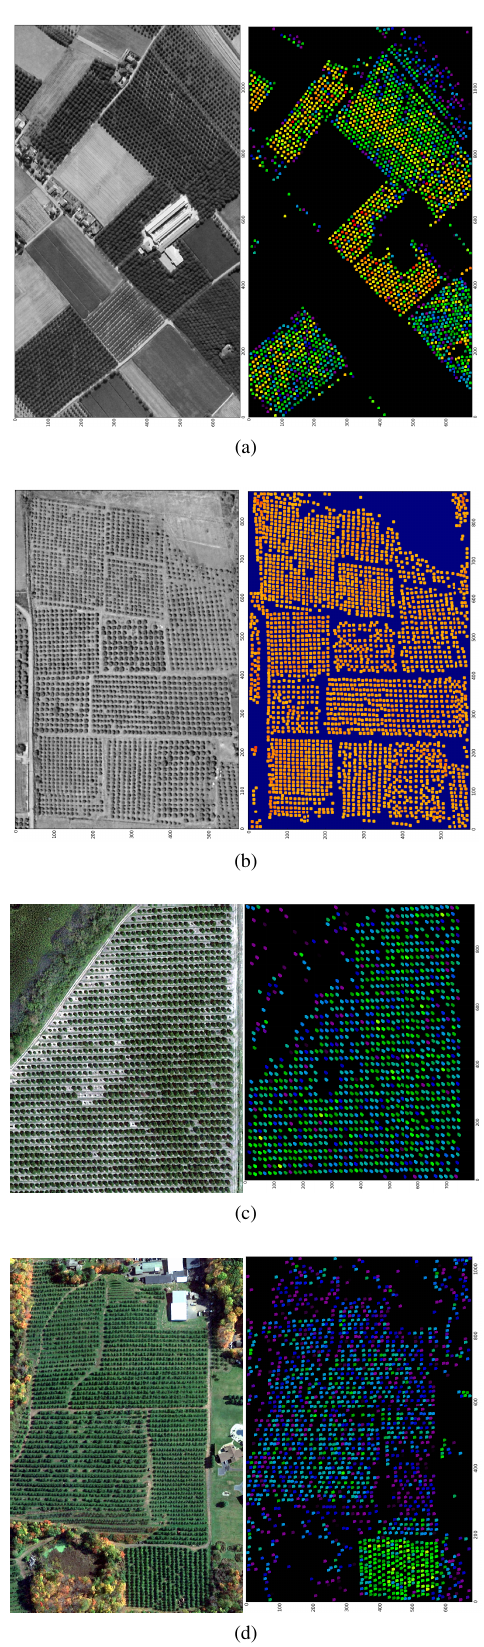
Figure 2: Results of the tree counting algorithm for the four test images: a) Grenoble, b) Juazeiro, c) Citrus Grove, d) Southing- ton. The left column shows the original images while the right one shows the colour-coded results where warmer colours repre- sent higher similarity